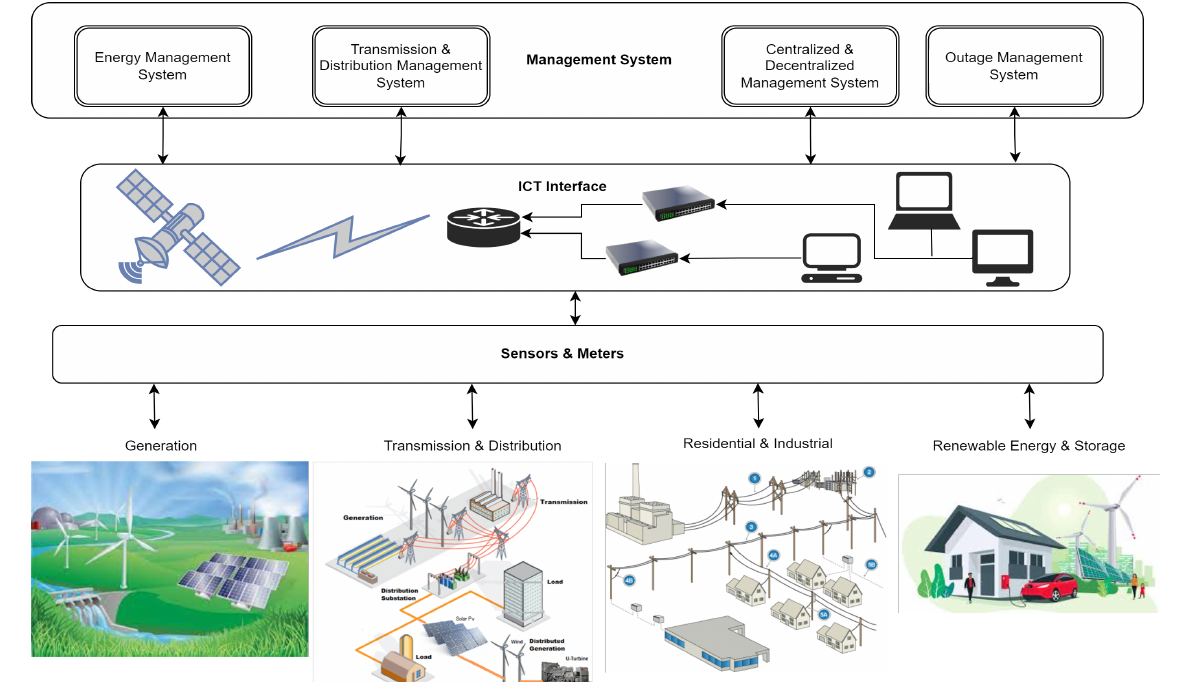
Figure 1. General illustration of smart grid infrastructure.